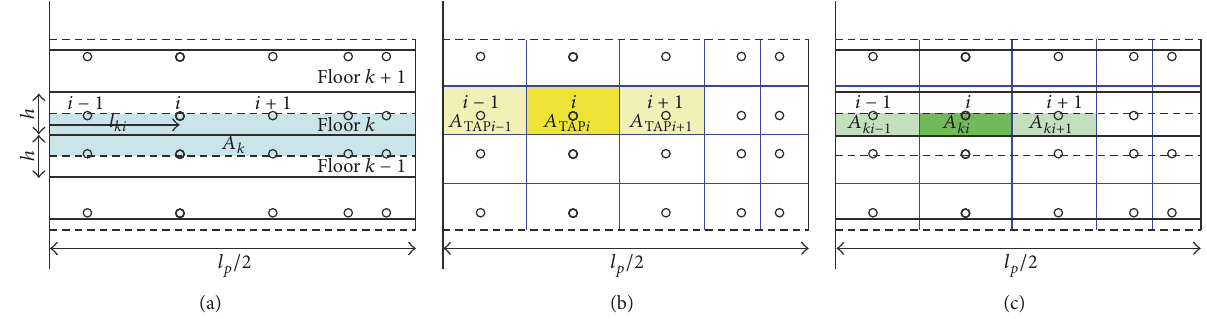
Figure 5: (a) Area of influence of the 𝑘 -floor 𝐴 𝑘 . (b) Area of influence of the 𝑖 -TAP 𝐴 TAP 𝑖 . (c) Area 𝐴 𝑘𝑖 obtained by the intersection of 𝐴 𝑘 and 𝐴 TAP 𝑖 .